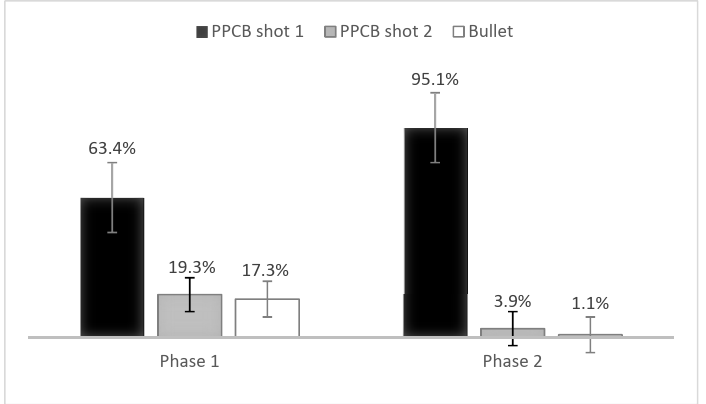
Figure 4. Stunning efficacy at first shot, second shot, and with firearm (bullet) for phases 1 and 2 of the study. Standard error bars are presented.